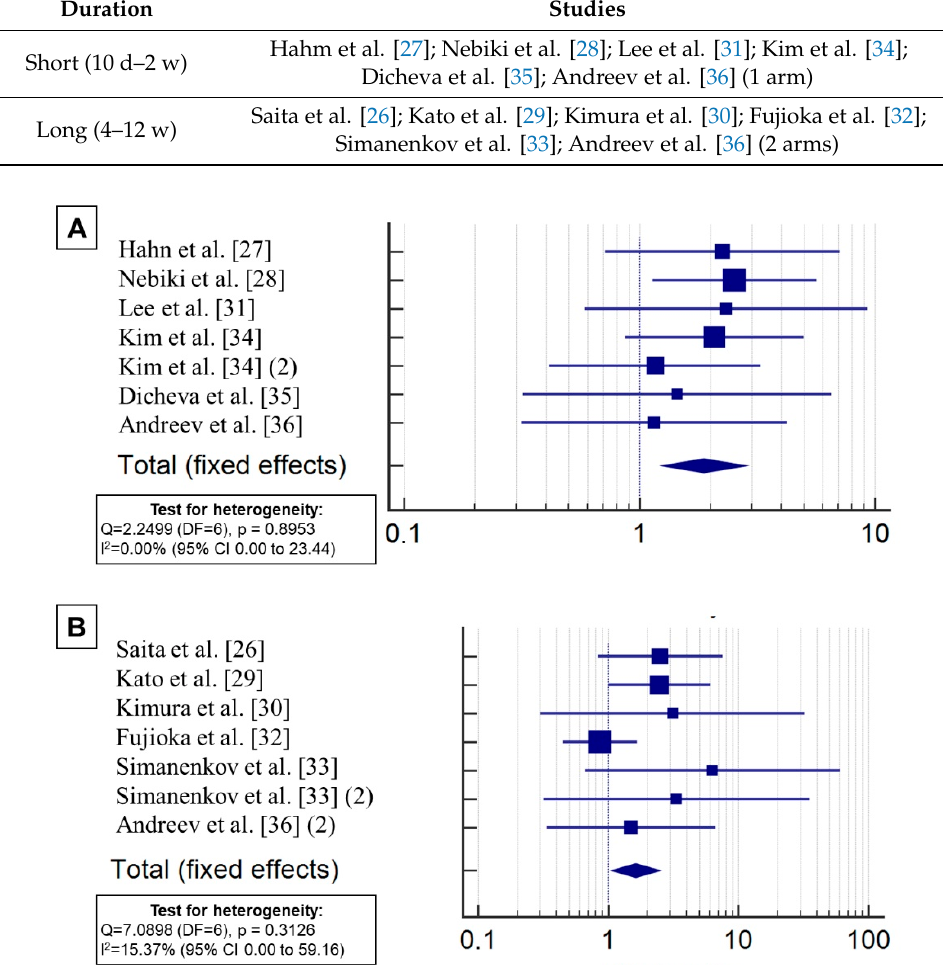
Table 2. Analysis of selected studies regarding the duration of rebamipide use.